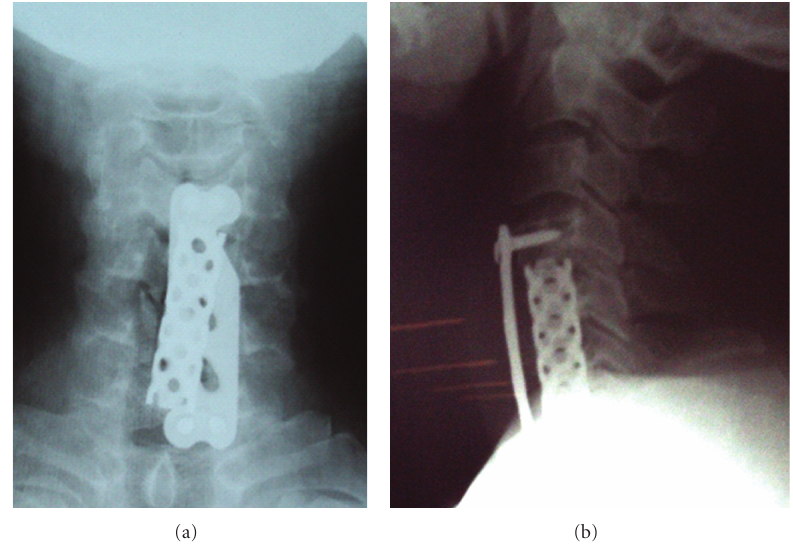
Figure 4: One year postoperative AP view and lateral